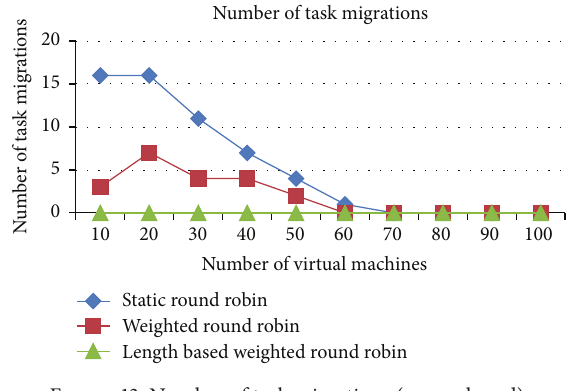
Figure 13: Number of task migrations (space shared).